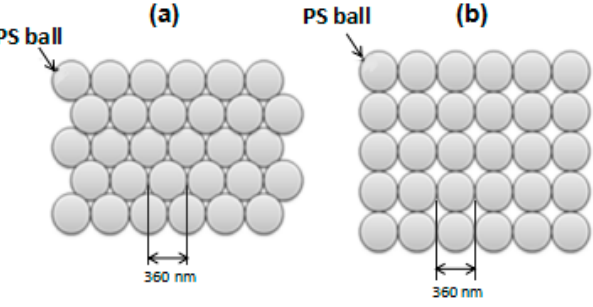
Figure 6. Two different arrangements of polystyrene (PS) nanospheres for the generations of: ( a ) hexagonal lattice of triangular; and ( b ) square lattice of quadrate Ag–Au hybrid nanoparticles